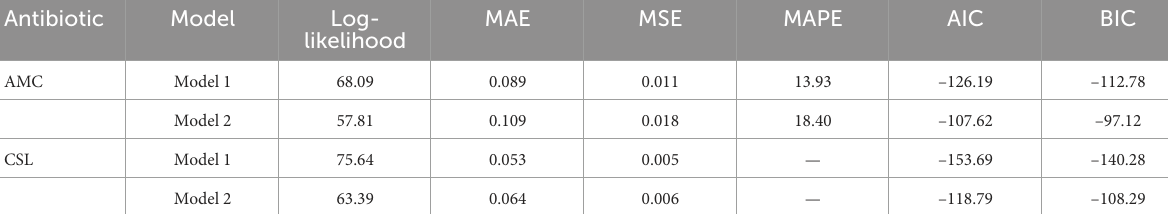
TABLE 5 Model selection